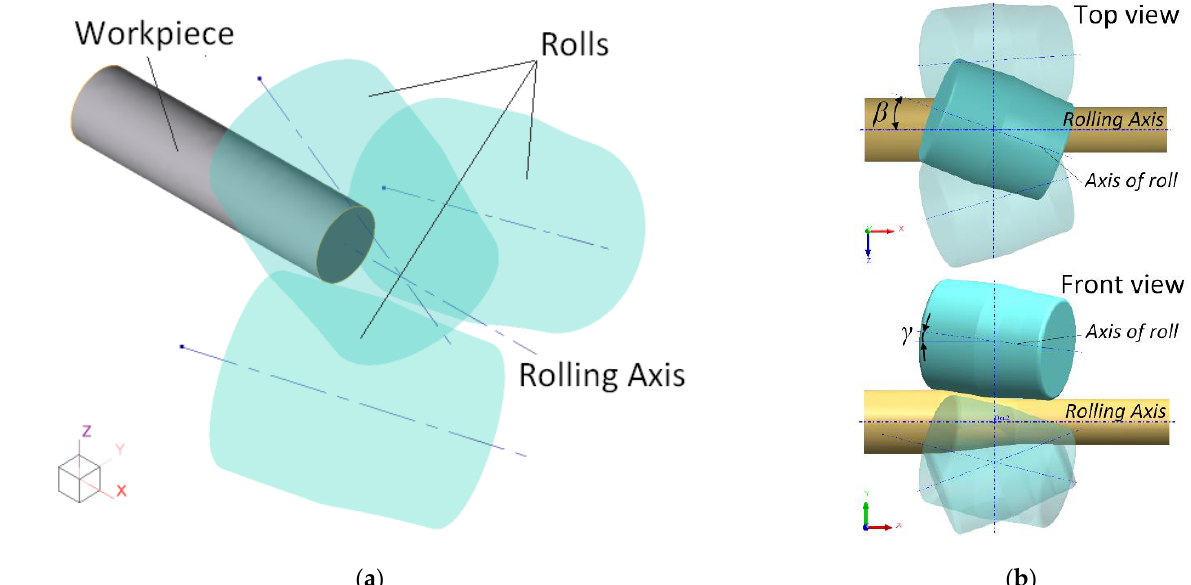
Figure 1. Resistance to deformation of Al-Zn-Mg-Ni-Fe alloy at deformation temperature: ( a ) 400 °С; ( b ) 450 °С; ( с ) 500 °С.